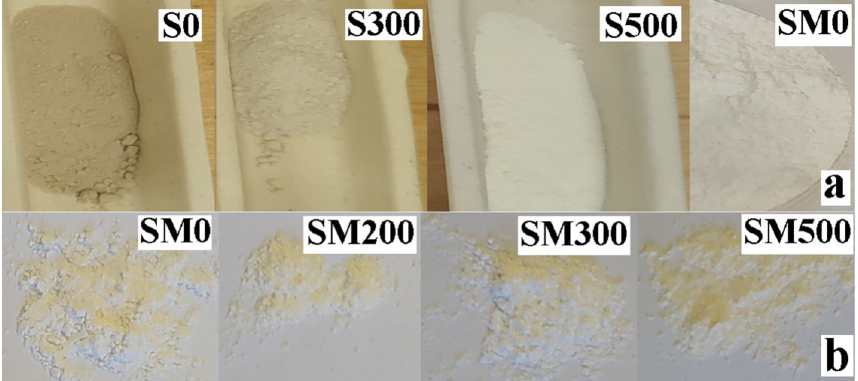
Figure 1. ( a ) Change in the color of the CeF3 NP (sample S0) from the annealing temperature in air; ( b ) color change in SM0 sample from commercial powder (Cerium (III) fluoride-anhydrous powder, 99.99% trace metal basis, Sigma-Aldrich) from air-annealing temperature.